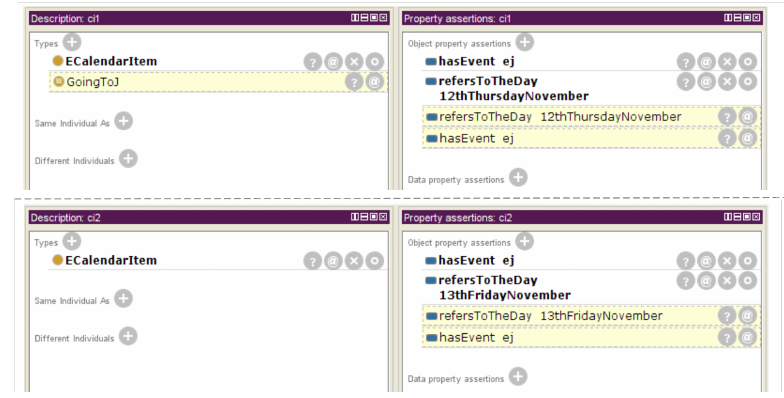
Figure 7. Individuals c 1 classified as an instance of GoingToJ.